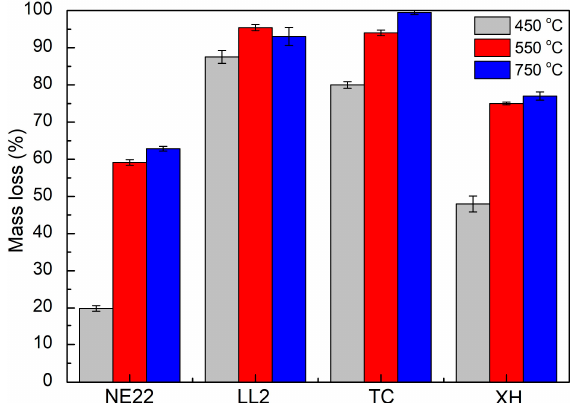
Figure 6. Mass loss of NE22, LL2, TC, XH belts during thermal decomposition and combustion at 450, 550, and 750 °C.